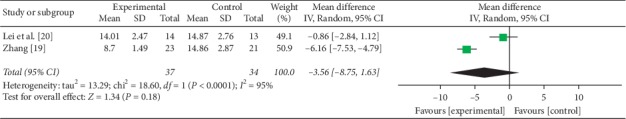
Forest plot of CBS.